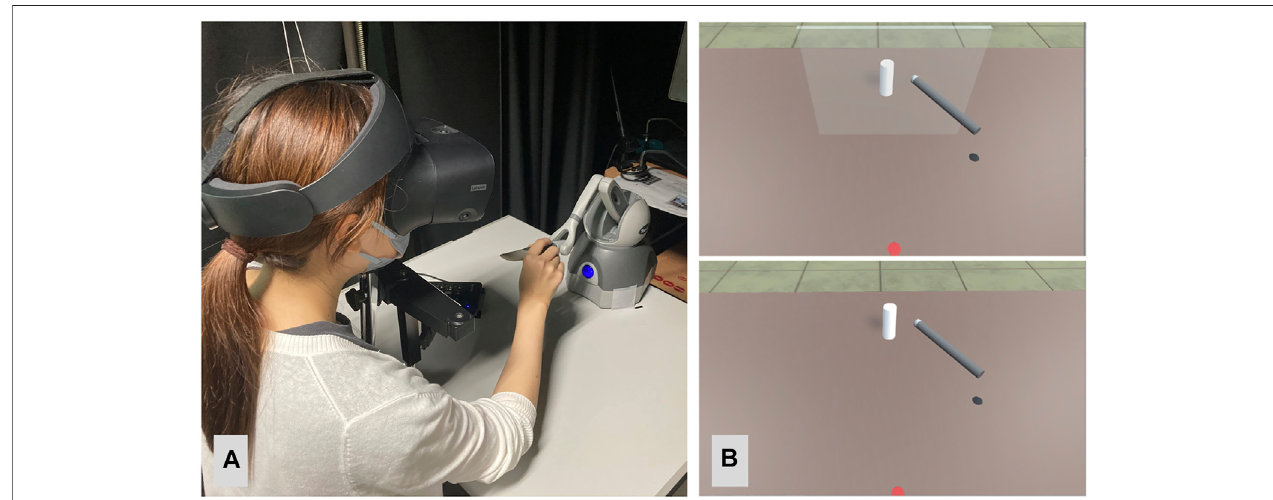
FIGURE 1 | The haptic task. The left fi gure shows the haptic task environment (A) . Participants controlled a pen-like manipulator and tactilely recognized the presence and width of a barrier. The two fi gures on the right show the virtual environment that the participant saw through the HMD in the haptic task (B) . The grey pen presented in the virtual environment moved synchronously with the manipulator. The upper fi gure shows the visible barrier condition, and the bottom fi gure shows the invisible barrier condition. Haptic feedback was generated when the grey pen encountered the visible or invisible barrier in Experiment 1, and no haptic feedback was generated when the pen encountered the visible barrier in Experiment 2.